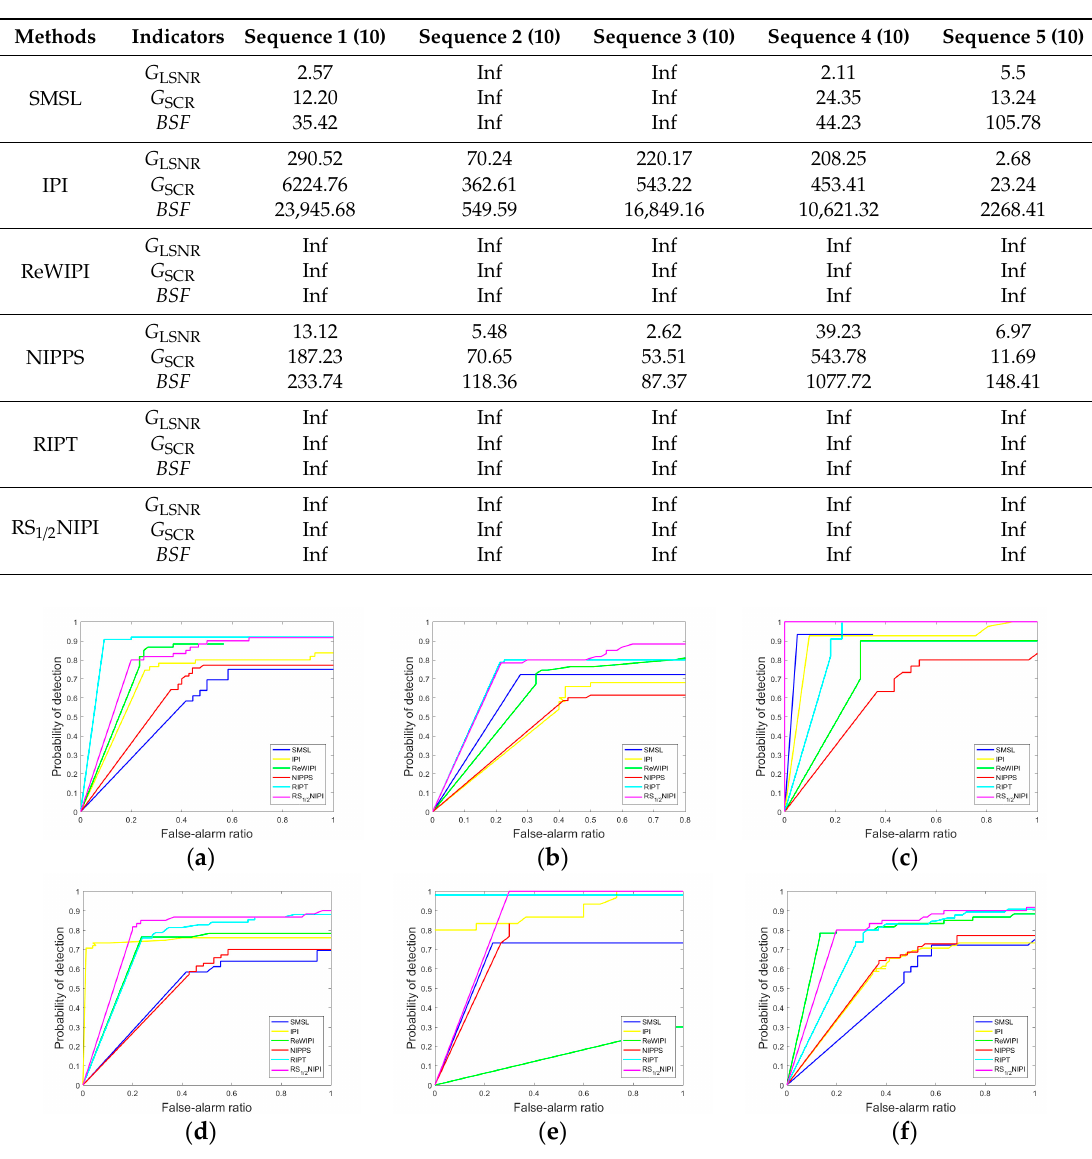
Table 3. Quantitative indicators of the di ff erent methods in term of G LSNR , G SCR and BSF .